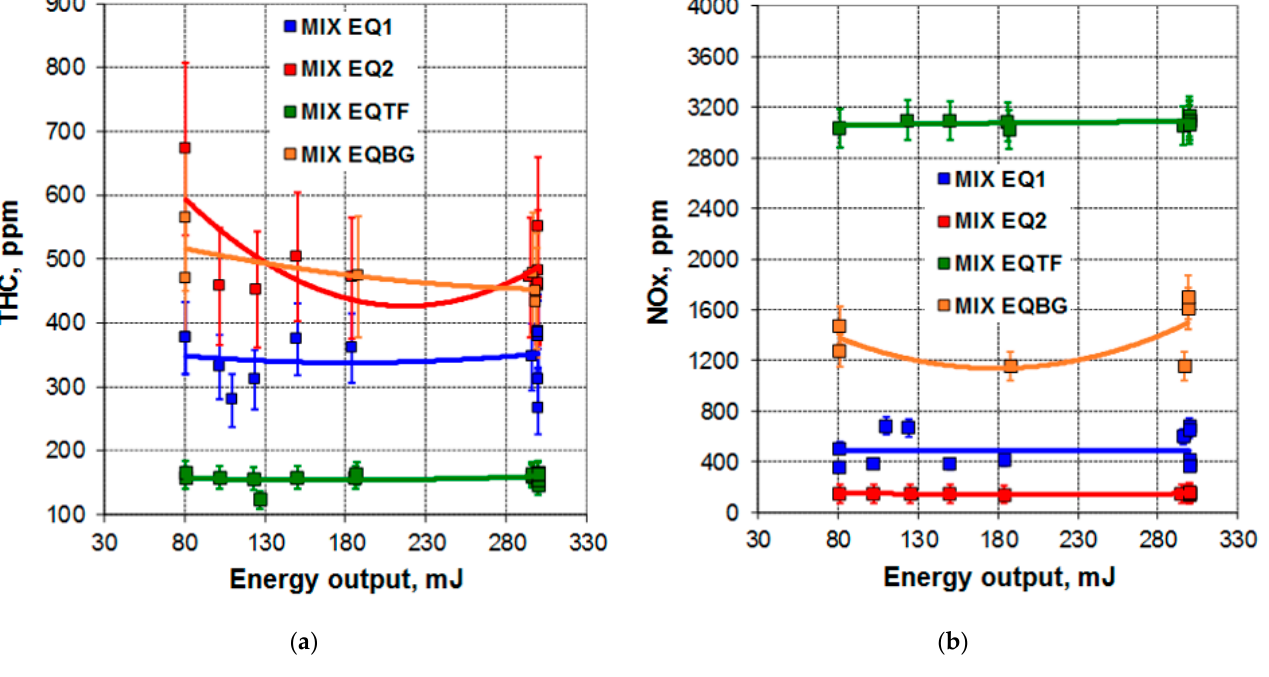
Figure 9. Measured emissions as a function of the ignition energy for operation with the equivalent mixtures at 1500 rpm and MAP 1250 mbar: ( a ) THC; ( b ) NOx.